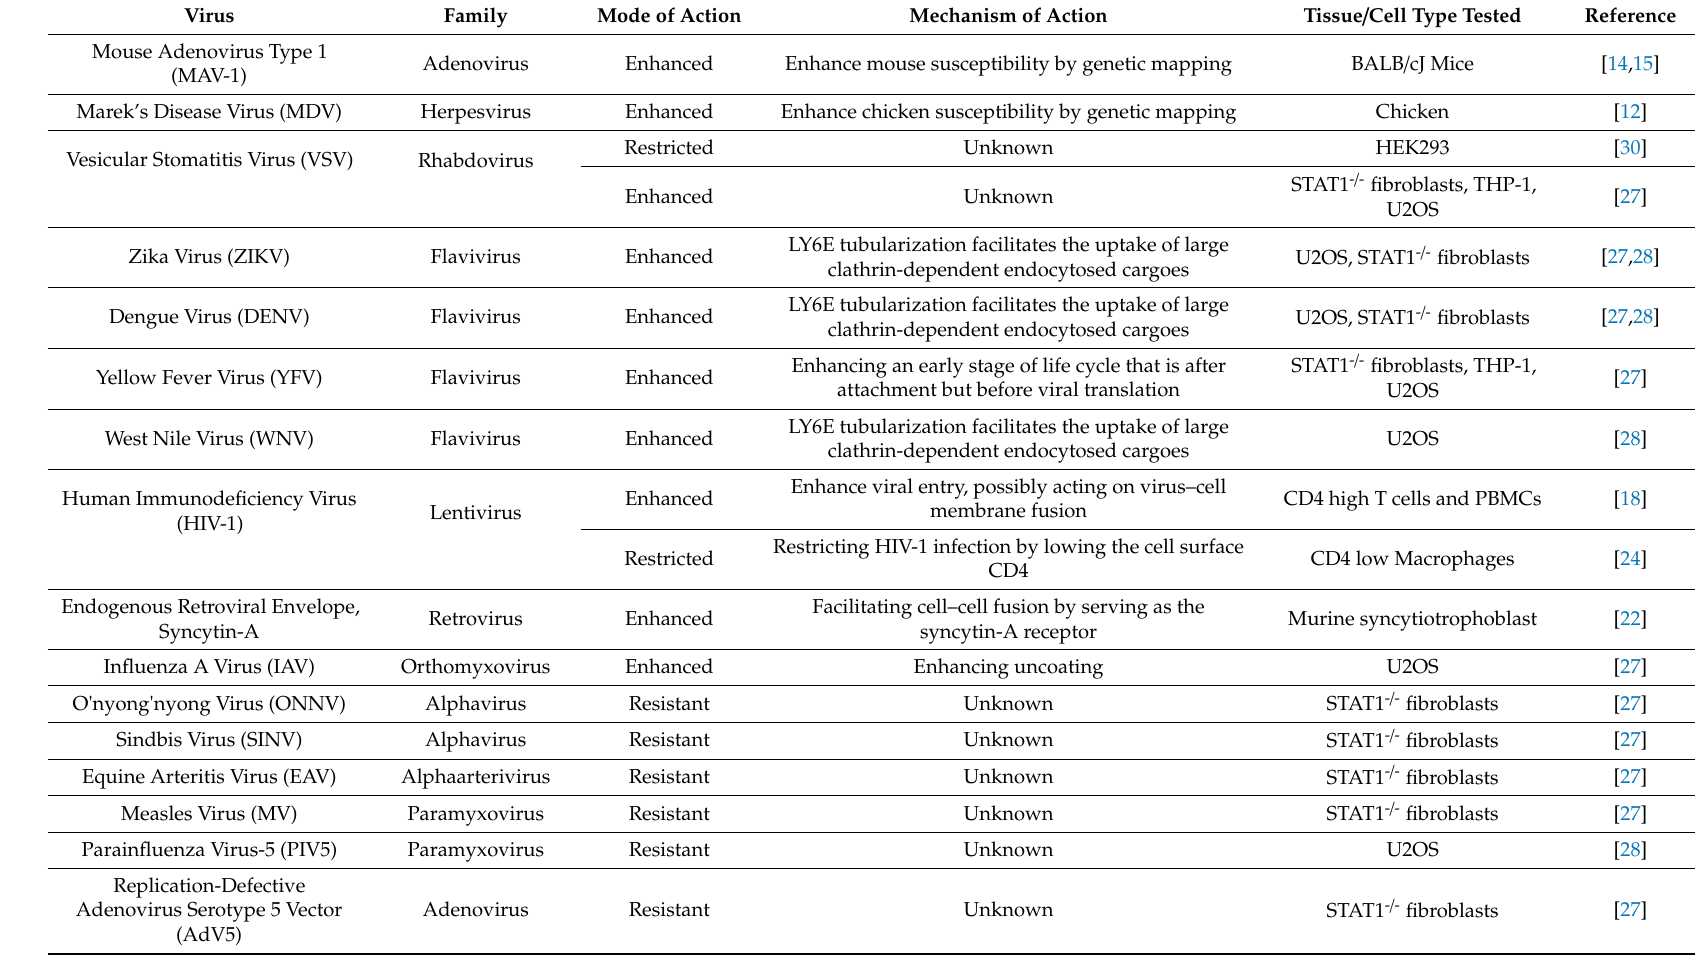
Table 1. Summary of the e ff ects of LY6E on viral